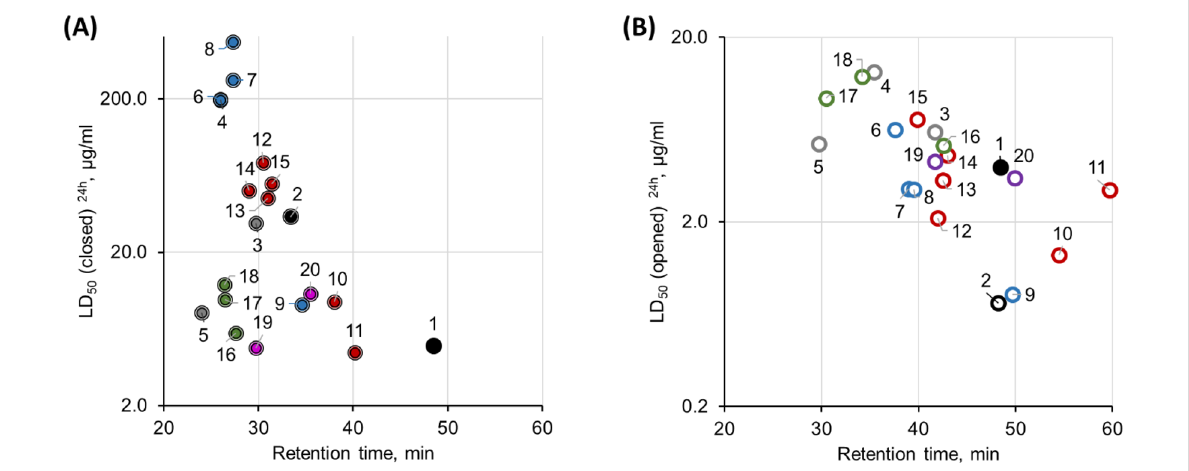
Figure 3: The in vivo toxicity against D. rerio embryos appears to be correlated with the empirical hydrophobicities of GS 1 and its photoswitchable analogues 2 – 20 . LD 50 values are plotted against the HPLC (C 18 ) retention times upon elution with a standardized linear water/acetonitrile gradient: both, for the ring-closed photoforms (A, filled circles), as well as for the ring-open photoforms (B, open circles). The compound numbers are shown next to the data points. Values for the parent peptide 1 are shown as black filled circles; the original prototype 2 is color-coded in black; the data points for peptides of series i ( 3 – 5 ) are shown in grey, series ii ( 6 – 9 ) in blue, series iii ( 10 – 15 ) in red, series iv ( 16 – 18 ) in green, and series v ( 19 , 20 ) in purple.